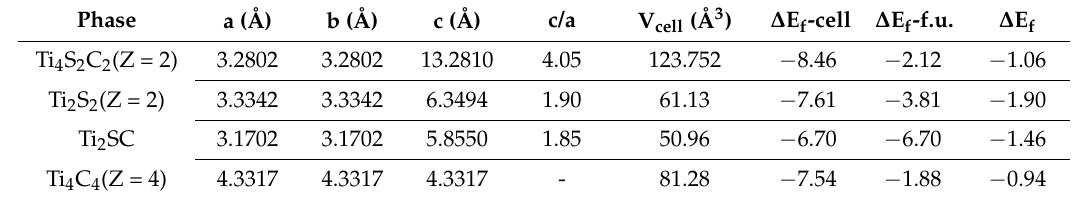
Table 1. Calculated lattice constants, c/a, volume, formation enthalpy for unit cell ∆ E f -cell (eV/cell), formation enthalpy for formula unit (f.u.) ∆ E f -f.u. (eV/f.u.) and formation enthalpy ∆ E f (eV/atom) of the phases.